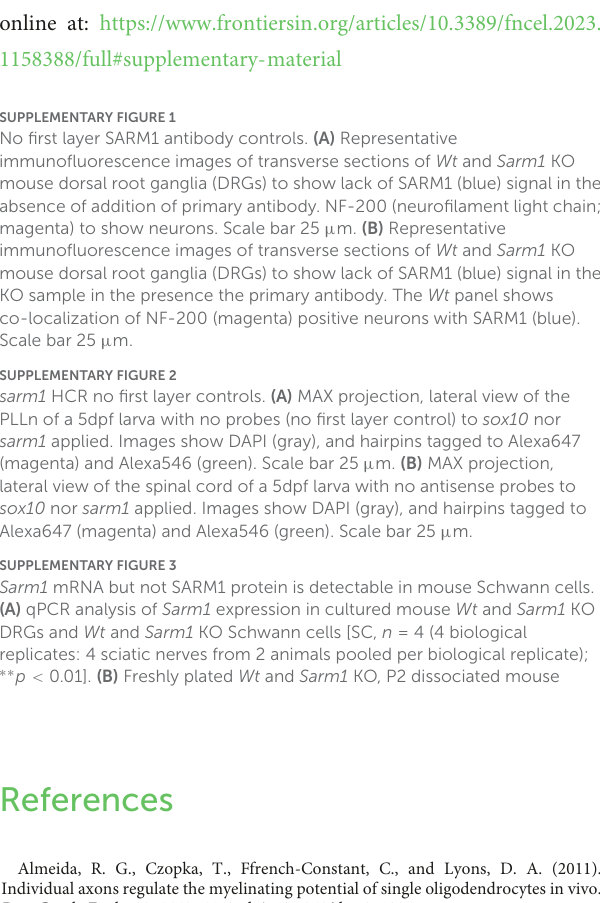
SUPPLEMENTARYFIGURE4 Cultured Schwann cells are insensitive to 3-AP induced cell death. (A) Dissociated and freshly plated P2 mouse Schwann cells cultured in defined